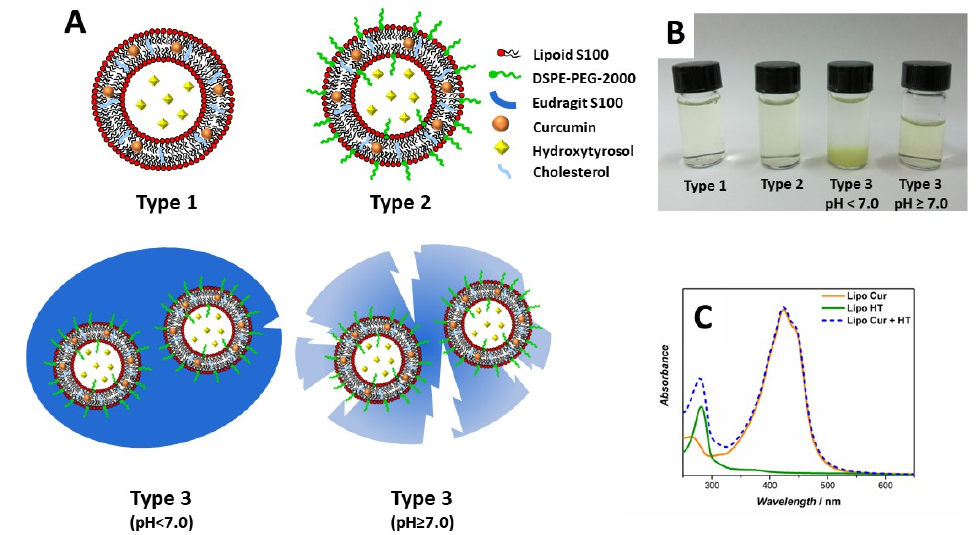
Figure 1. ( A ): Sketch illustrating the composition of the different types of liposomes tested. Type 1: LS100 (4 mg/mL) + Chol (10% mol); Type 2 LS100 (4 mg/mL) + Chol (10% mol) + 1 ,2-distearoyl-sn-